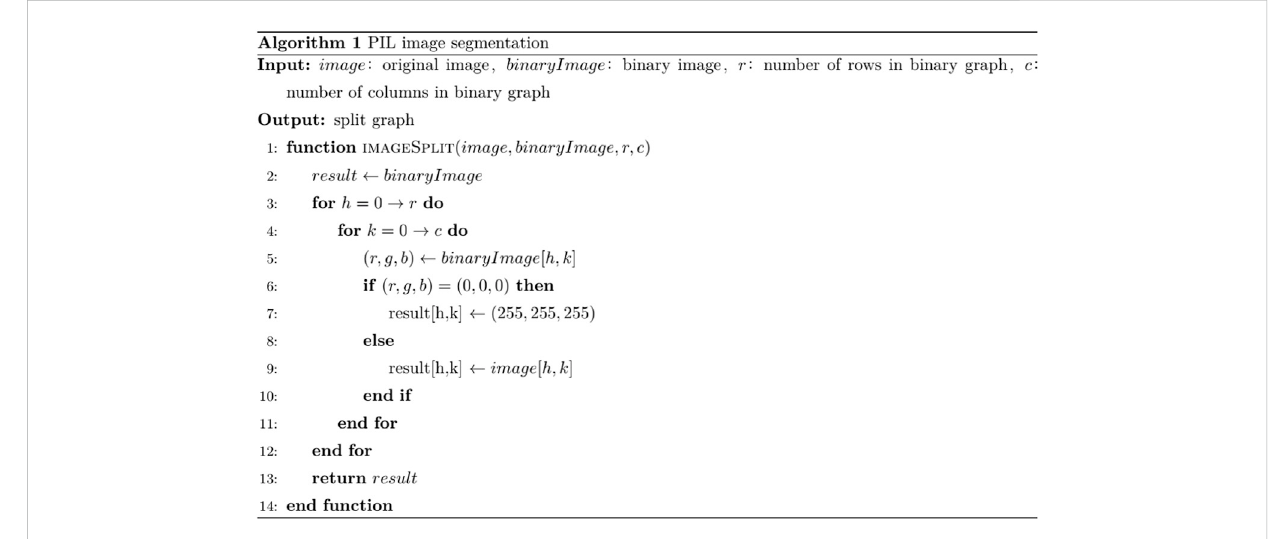
FIGURE 5 The pseudo-code of the proposed method.